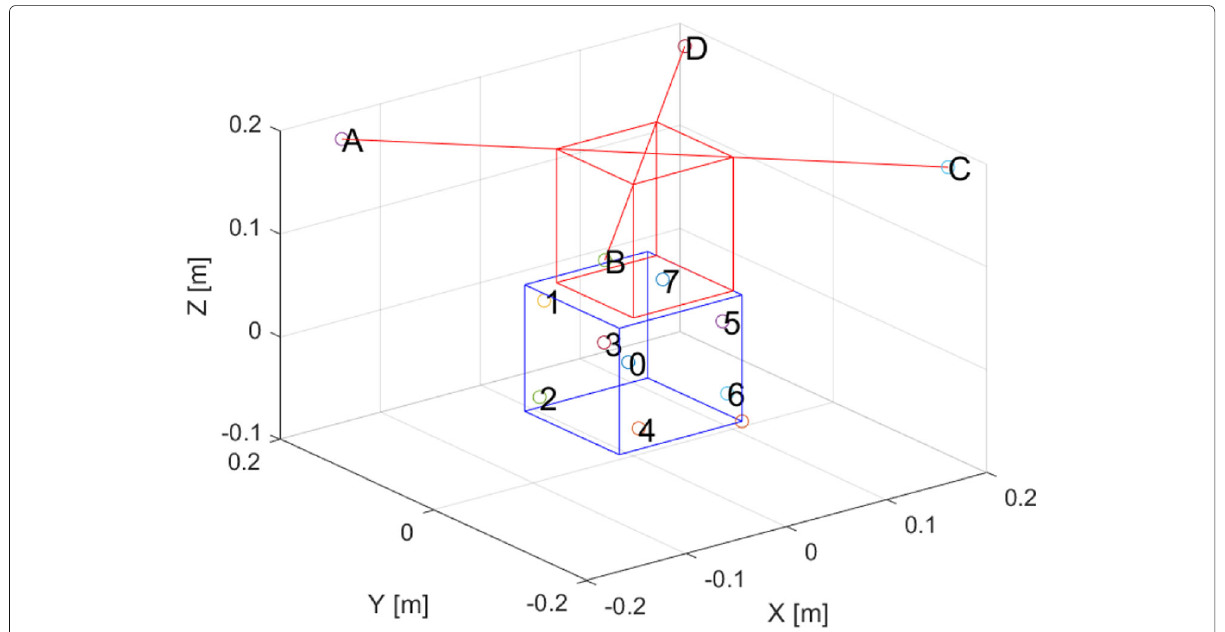
Fig. 7 Microphone array (0–7) and rotor (A–D) geometry overview. Figure provided by SPCup syllabus [1]